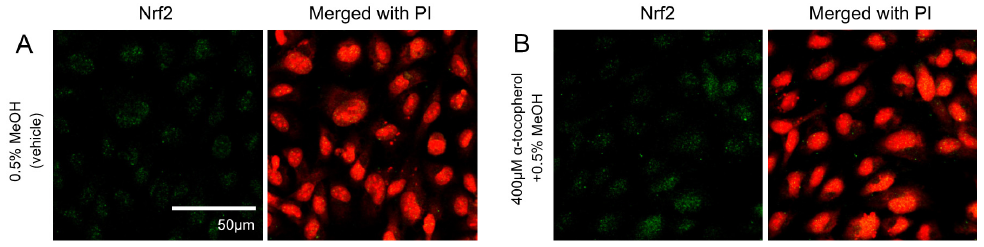
Figure 2. Reactive oxygen species (ROS) generation in HUVECs. Cells were incubated with 0.5% MeOH, tertiary butylhydroperoxide (TBHP), AA, EPA, 5 ‐ HETE, or 5 ‐ HEPE, for 1 h after treatment with or without 400 μ M α‐ tocopherol for 1 h. ROS were detected using CellROX Green and measured with a flow cytometer, and the ratio of ROS positive cells to total live cell was represented as the percentage of ROS positive cells. Histograms of HUVECs treated with 0.5% MeOH (negative control) and 400 μ M TBHP (positive control) analyzed by flow cytometry are shown above the graph. Data are expressed as mean ± SD ( n = 4). * p < 0.05 compared with 0.5% MeOH; † p < 0.05 compared with 400 μ M TBHP; # p < 0.05 and § p < 0.05 compared with 50 μ M 5 ‐ HETE and 50 μ M 5 ‐ HEPE, respectively. Statistical analysis was performed with one ‐ way ANOVA followed by Tukey’s test.